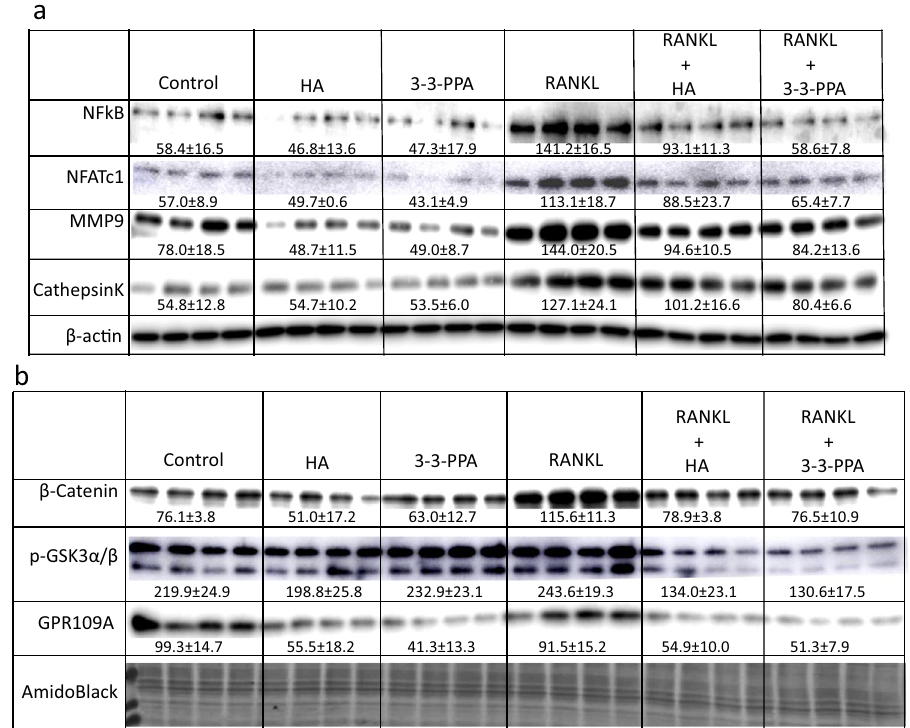
Fig. 6 GPR109A-mediated inhibition of RANKL-induced osteoclastogenic signaling by HA and 3-3-PPA. Non-adherent bone marrow cells were isolated from 4-week old male wild type mice, cells were treated with HA or 3-3-PPA (HA, 60 µ g/dL; 3-3-PPA, 100 µ g/dL) in the presence or absence of 50 ng/ml RANKL for 48 h. a Western blot shows RANKL activated NF κ B, NFATc1, MMP9 and Cathepsin K protein expression. Both HA and 3-3-PPA inhibited RANKL-induced protein expression. b Western blot shows inhibition of β -catenin and GSK3 α / β and GPR109A expression by HA and 3-3-PPA in the presence of 50 ng/ml RANKL. Numbers under blots are mean ± SD band intensities relative to loading